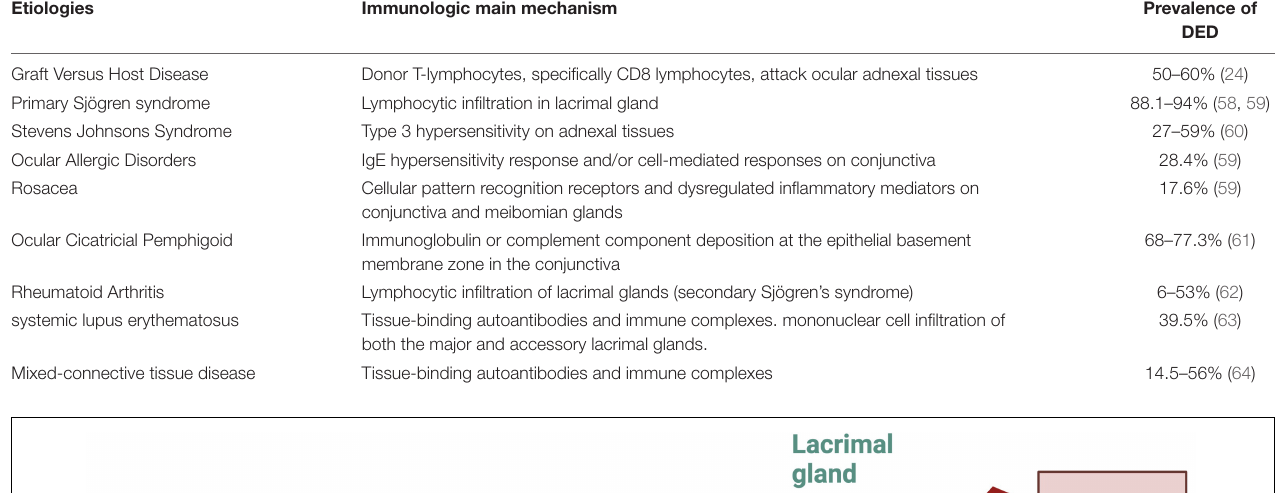
TABLE 1 | Ocular surface inflammatory disorders (OSID) and “reported prevalence” of dry eye disease.